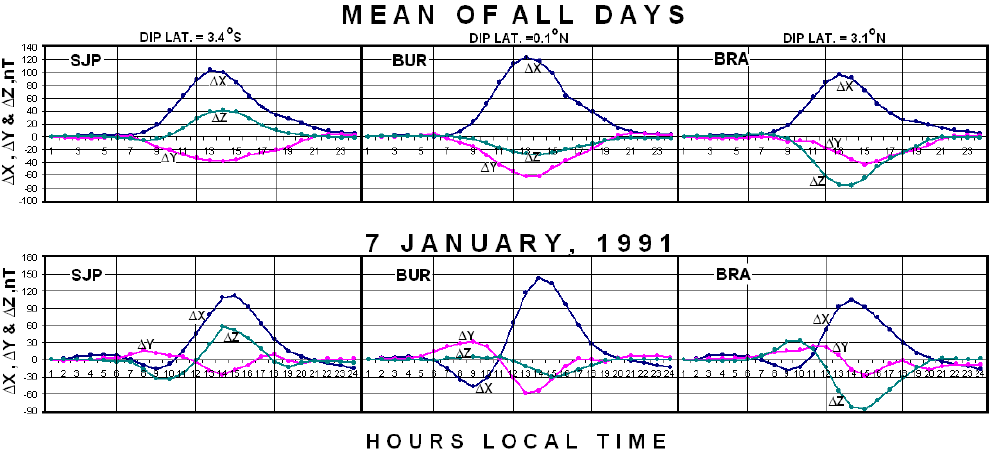
Fig. 4b. Daily variations of 1X , 1Y and 1Z at southern fringe station SJP, equatorial station BUR and northern fringe station BRA, averaged over all days and on an individual day 7 January